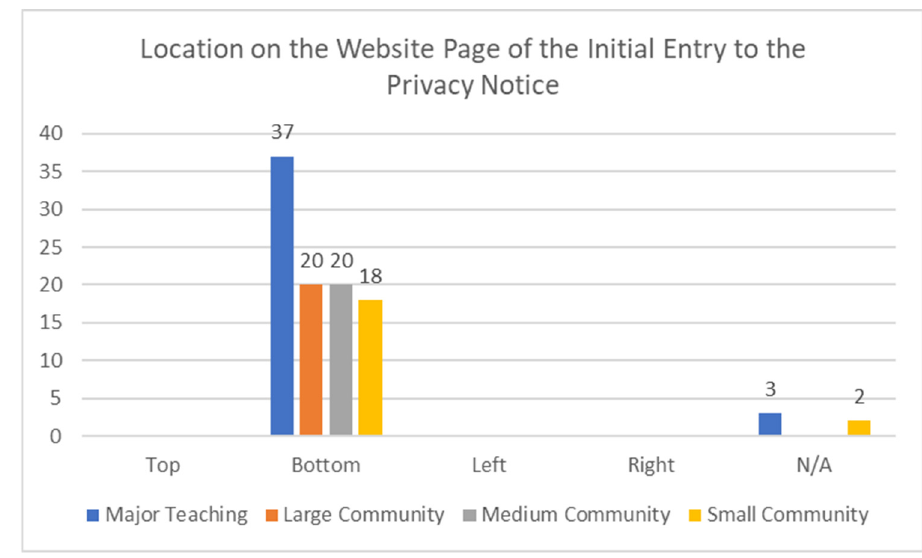
Figure 4. Location on the Website page of the Initial Entry.